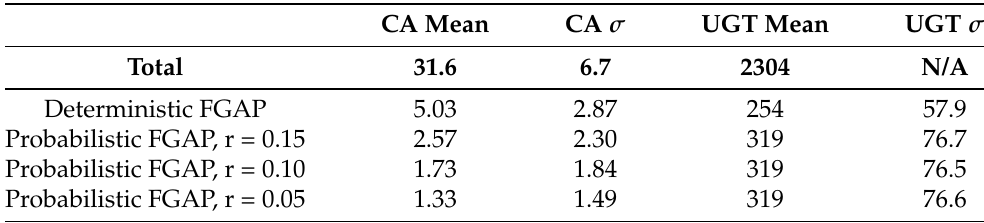
Table 5. Metric results for the FGA’s at RTM airport, averaged over the days from 14 July until 12 August 2019 (30 days). The mean and standard deviation of the number of conflicted aircraft (CA) and the number of Used Gate Time slots (UGT) are shown for all methods. For reference, the total number of aircraft per day and the total number of available gate time slots are added. The presence probabilities were constructed using